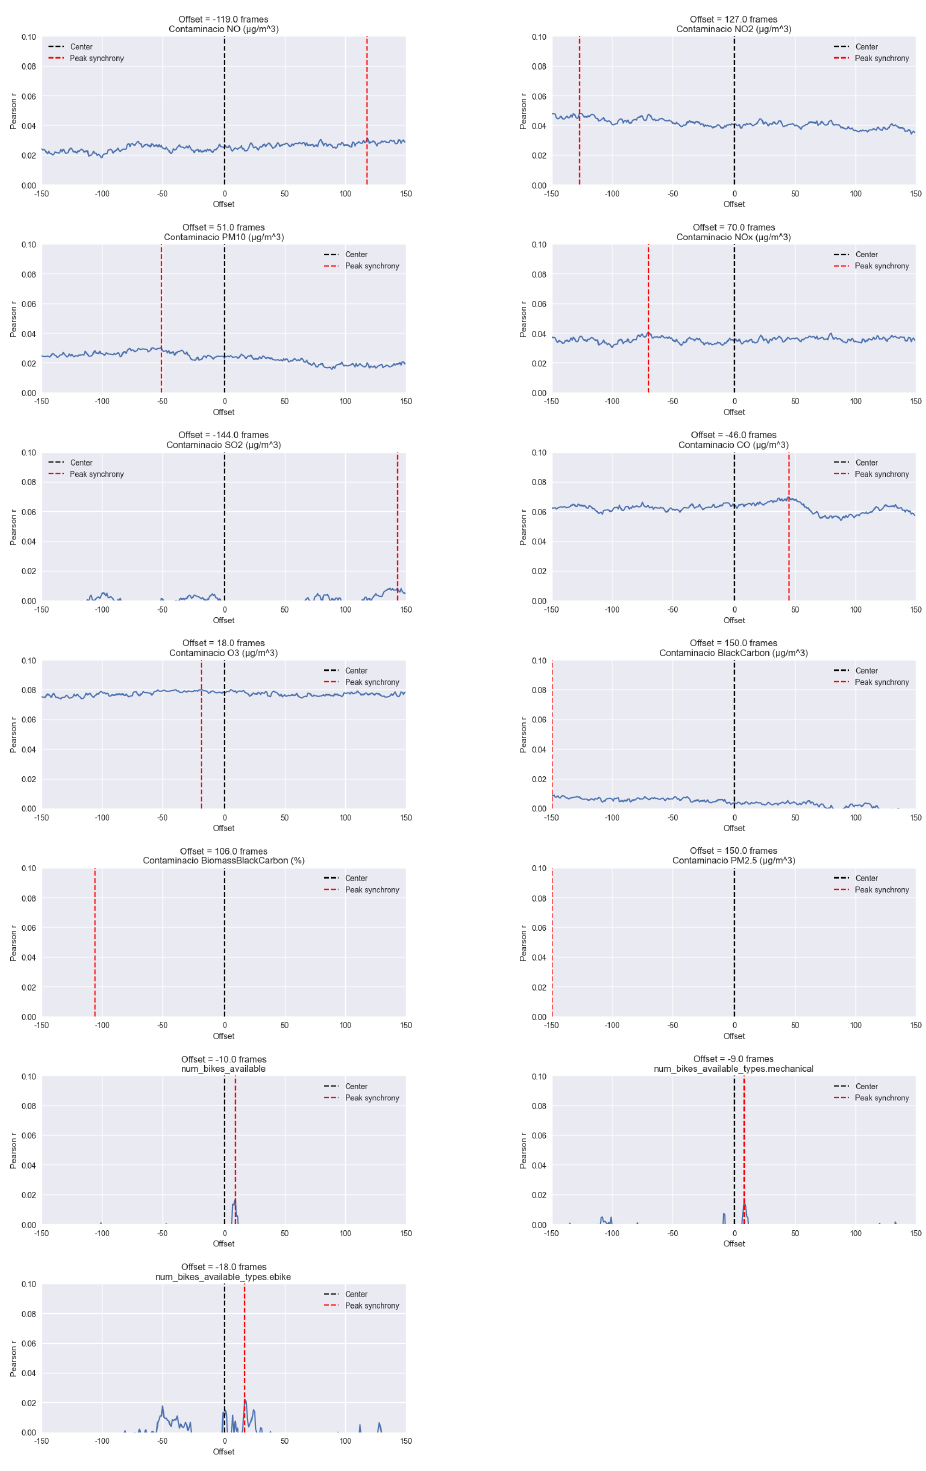
Figure A2. Overall lagged cross-correlations for different variables in the resulting dataset compared to traffic